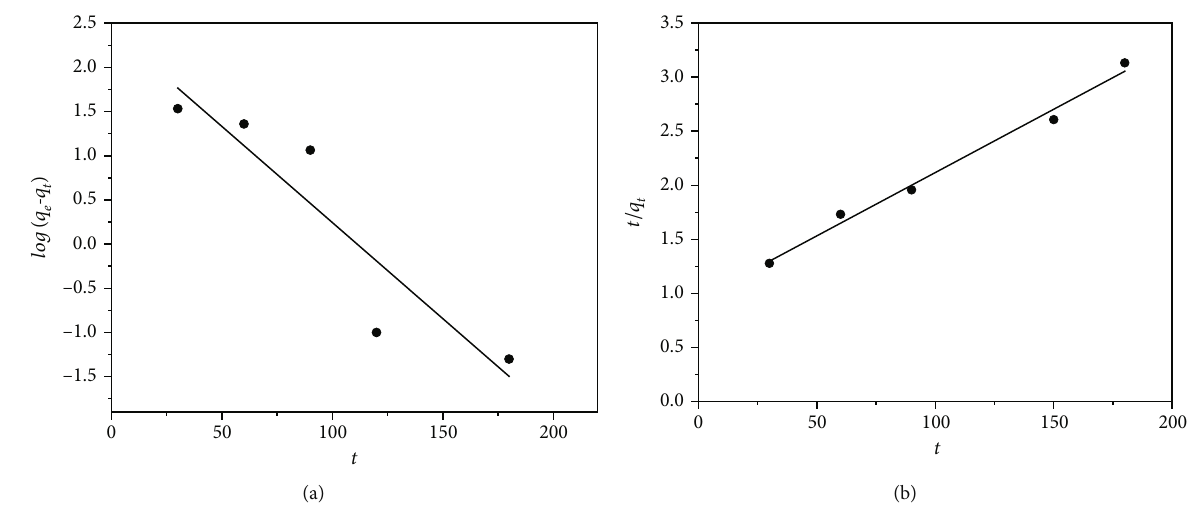
Figure 9: Adsorption kinetics: (a) pseudo- fi rst-order model and (b) pseudo-second-order